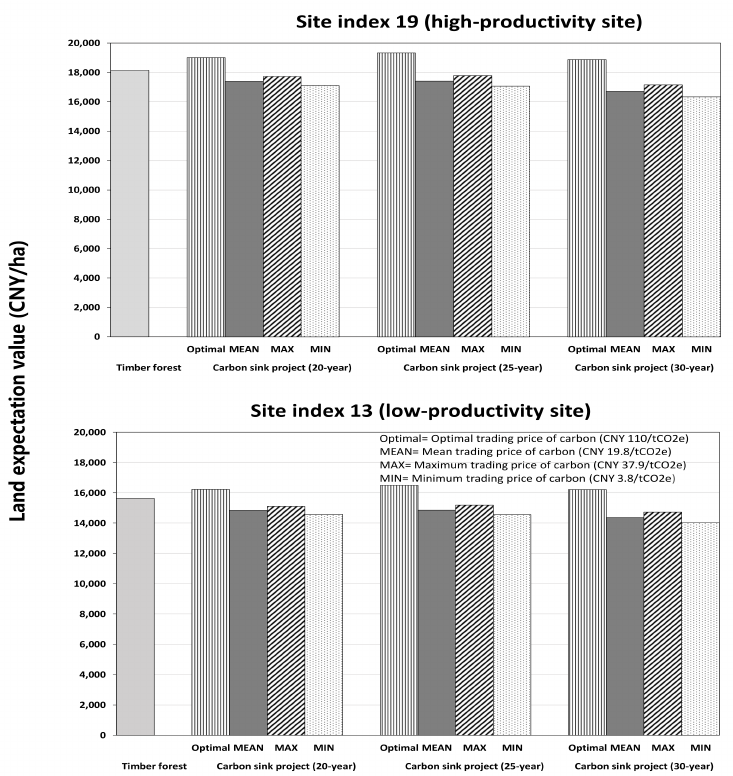
Figure 3. Maximum land expectation values of a larch timber production forest and a larch carbon sink forest at the optimal rotation age under different carbon trading prices and site conditions in Gansu, Northwest